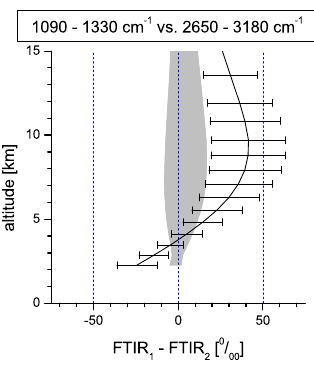
Fig. 17. Same as Fig. 14, but for δ D profiles retrieved in the 1090 - 1330 and 2650 - 3180 cm − 1 regions.